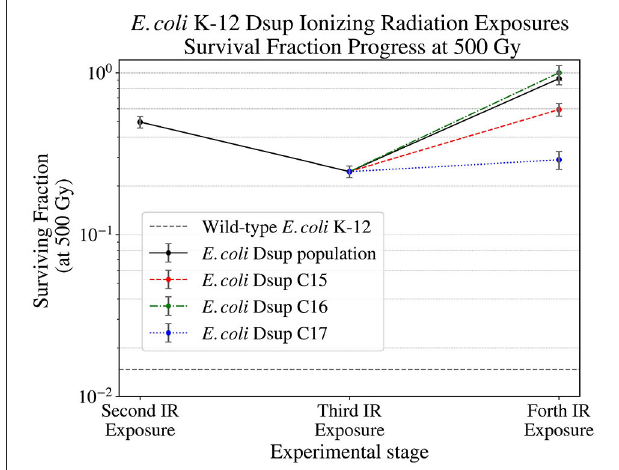
FIGURE 6 | Surviving fraction of the E. coli Dsup strain at 500 Gy (12.6 Gy/min) during the second, third, and final Ionizing Radiation exposures, showing the progress on the survival of this strain and its selected colonies.